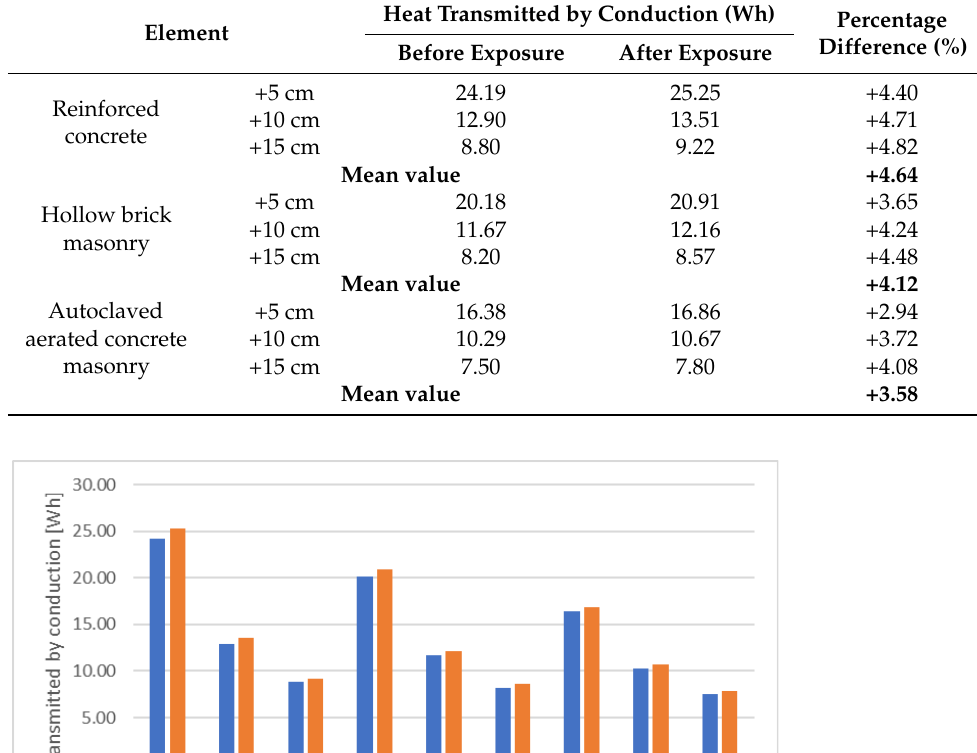
Table 6. Summary of heat transmitted by conduction before and after environmental exposure.